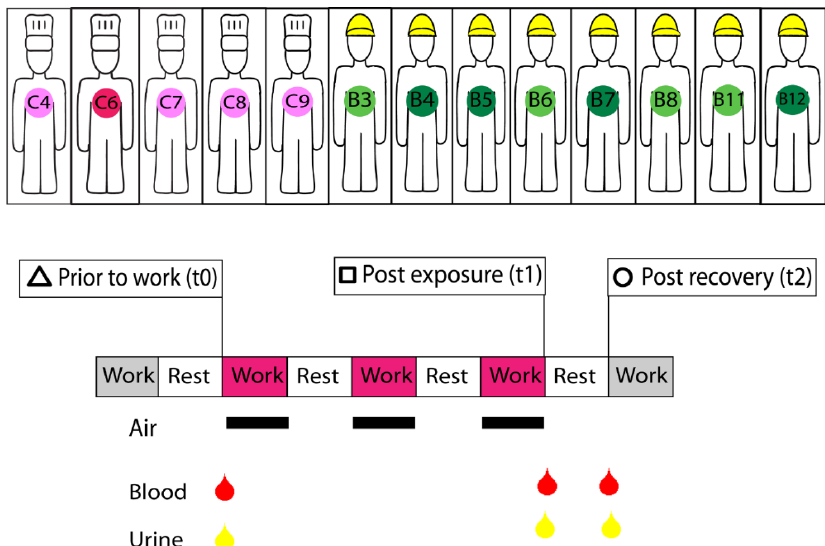
Figure 1. Study design. Biological samples were collected from five unexposed offshore caterers (left, pink) and eight exposed (right, green) tank workers. Lighter shades represent workers in the age balanced dataset while darker shades denote the individuals not included. Samples were taken before work shift (time 0, t 0 ), after three consecutive work shifts (time 1, t 1 ) and again after recovery of 12 h (time 2, t 2 ). Benzene concentration in tank workers’ breathing zone air was measured by passive dosimeter badges during all three work shifts. Benzene concentration was measured in blood and urine at all three sampling time points. RNA was extracted from blood taken at all three time points. Other parameters measured in blood include toluene, differential cell counts, immunoglobulins, and